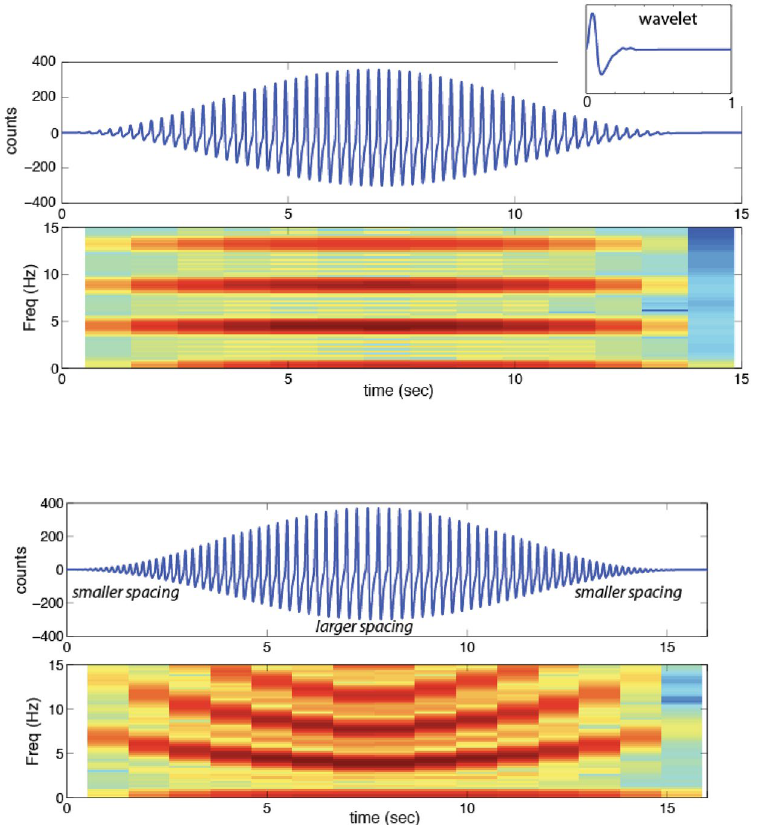
Figure 3. Example waveforms and spectra demonstrating wavelet model for generating repeating pulse harmonic signals. ( a ) Upper panel shows example of repeating pulse source model produced using a tapered amplitude sequence of wavelets of constant length. Upper right inset shows wavelet used (0.23 second for this demonstration). A series of these wavelets are aligned using constant inter-event time to construct the waveform below. A cosine taper is also used on the pulse series waveform. The frequency and overtones in the spectrogram of the waveform are inversely proportional to the time spacing of the maximum amplitude of the wavelets. ( b ) Upper panel shows a tapered amplitude sequence of wavelets with variable inter-event time (range from 0.16–0.23 sec). Lower panel shows resulting spectrogram with shifting frequencies due to change in wavelet time length in original